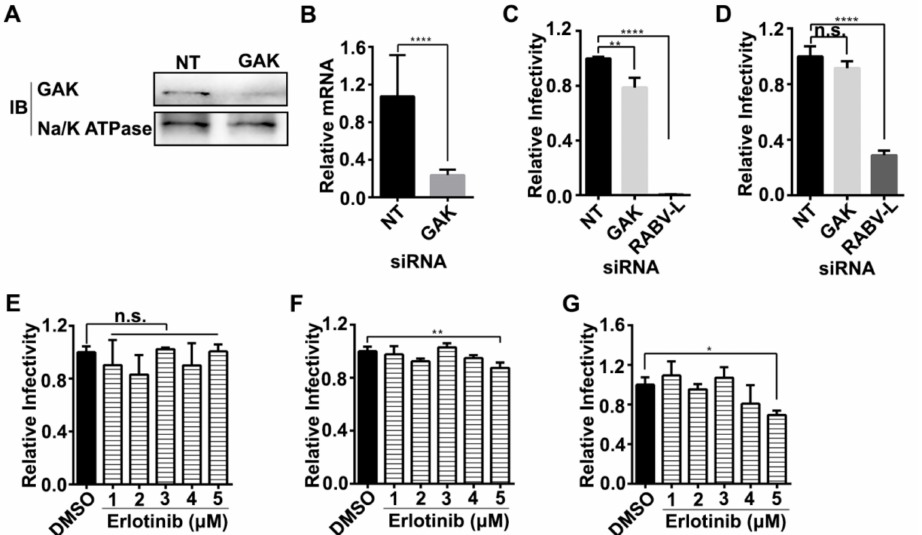
Figure 4. GAK has a minor e ff ect on RABV infection in vitro. ( A ) HEK293 cells were transfected